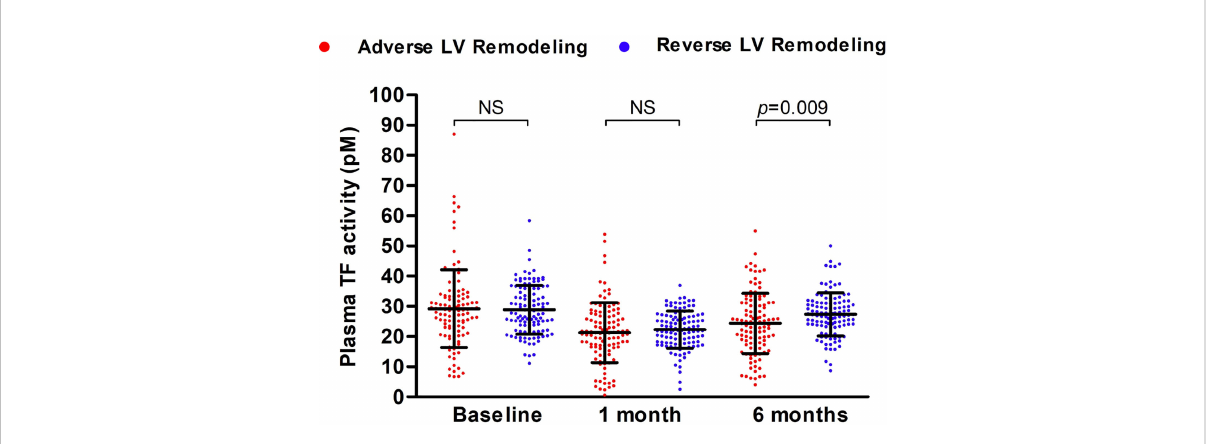
FIGURE 3 Plasma TF activity in patients with adverse versus reverse LV remodeling during 6-months follow-up. Plasma TF activity of patients with post-AMI adverse (n = 114) or reverse (n = 114) LV remodeling was presented as mean ± SD and statistically analyzed with unpaired t-test. NS, no signi fi